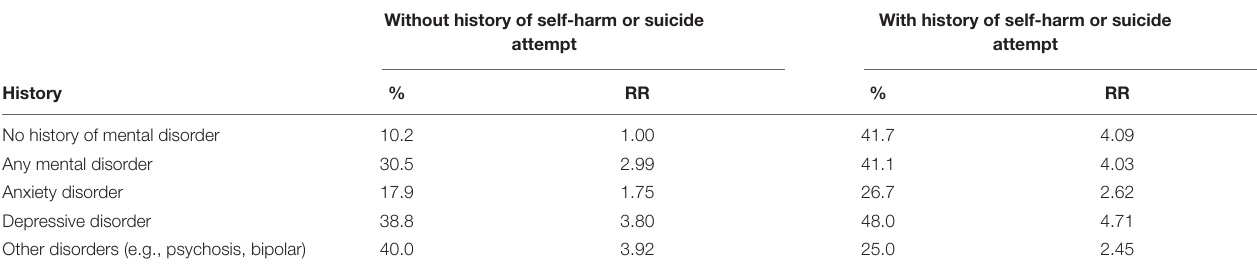
TABLE 6 | The relative risk to develop depression in people with history of various mental disorders versus participants with no mental health history. Without history of self-harm or suicide With history of self-harm or suicide attempt